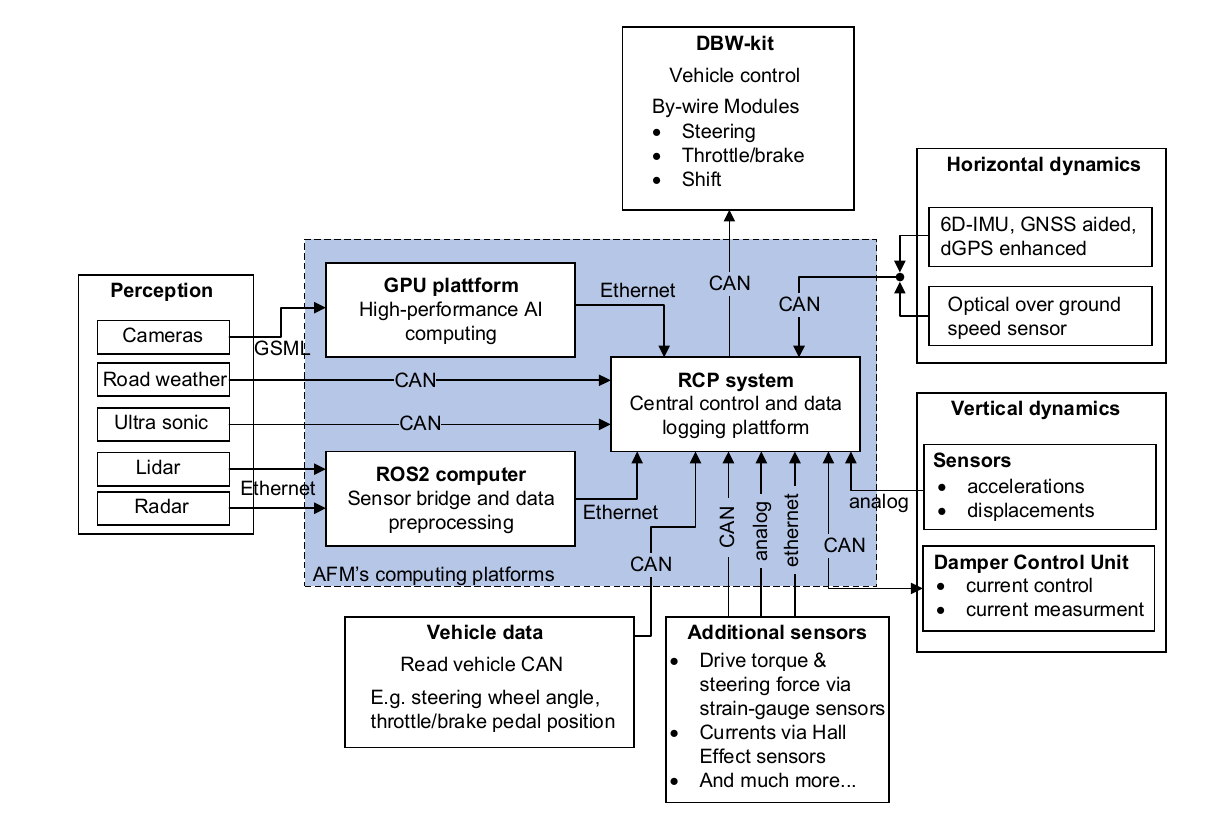
Figure 10. Overview of AFM’s network architecture.